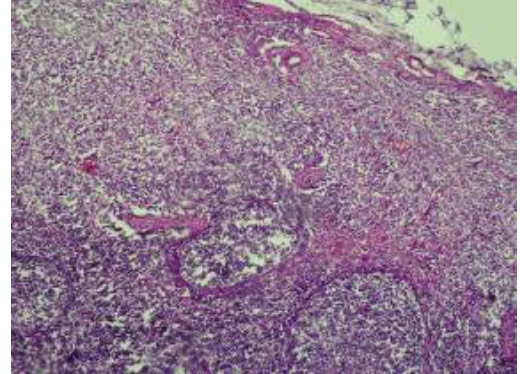
Fig. 10. Piglet lymph node, control group, the 70 th day of test. Cell devastation of lymphoid follicles. H&E. x 100